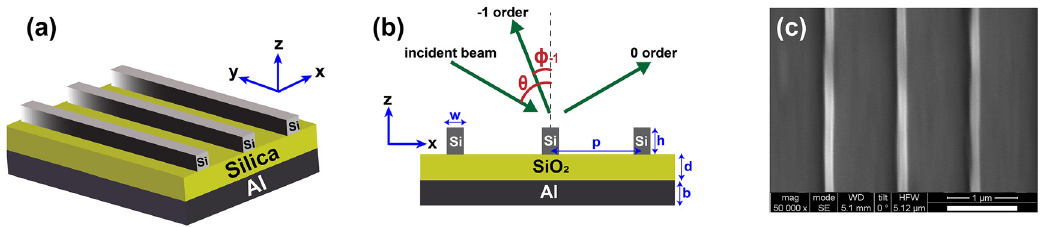
Figure 1: (a) 3D schematic of the structure, (b) 2D cross section of the structure along with the directions of the incident, 0th order reflected, and − 1storderdiffracted(de fl ected)beams,and(c)scanningelectronmicroscopy(SEM)imageofthefabricatedsample(topview).Welookfor the geometries that funnel the energy into the − 1st order, with minimum absorption in the metal and minimum ef fi ciency in the 0th order.